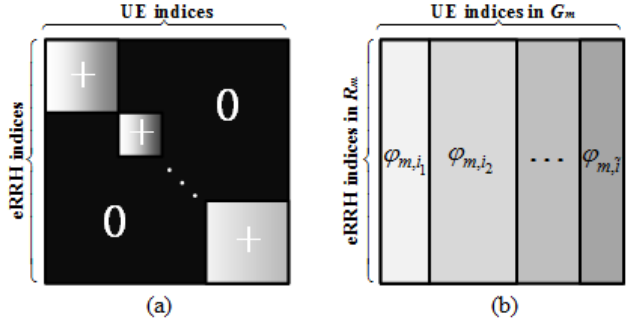
Figure 3. The structure of matrix A corresponding to the complete request data for the entire F-RAN. ( a ) presents the structure of the entire matrix; ( b ) is used to illustrate each positive sub-block with different shades of gray, the rows and the columns of the sub-block correspond to the users and the eRRHs in the same